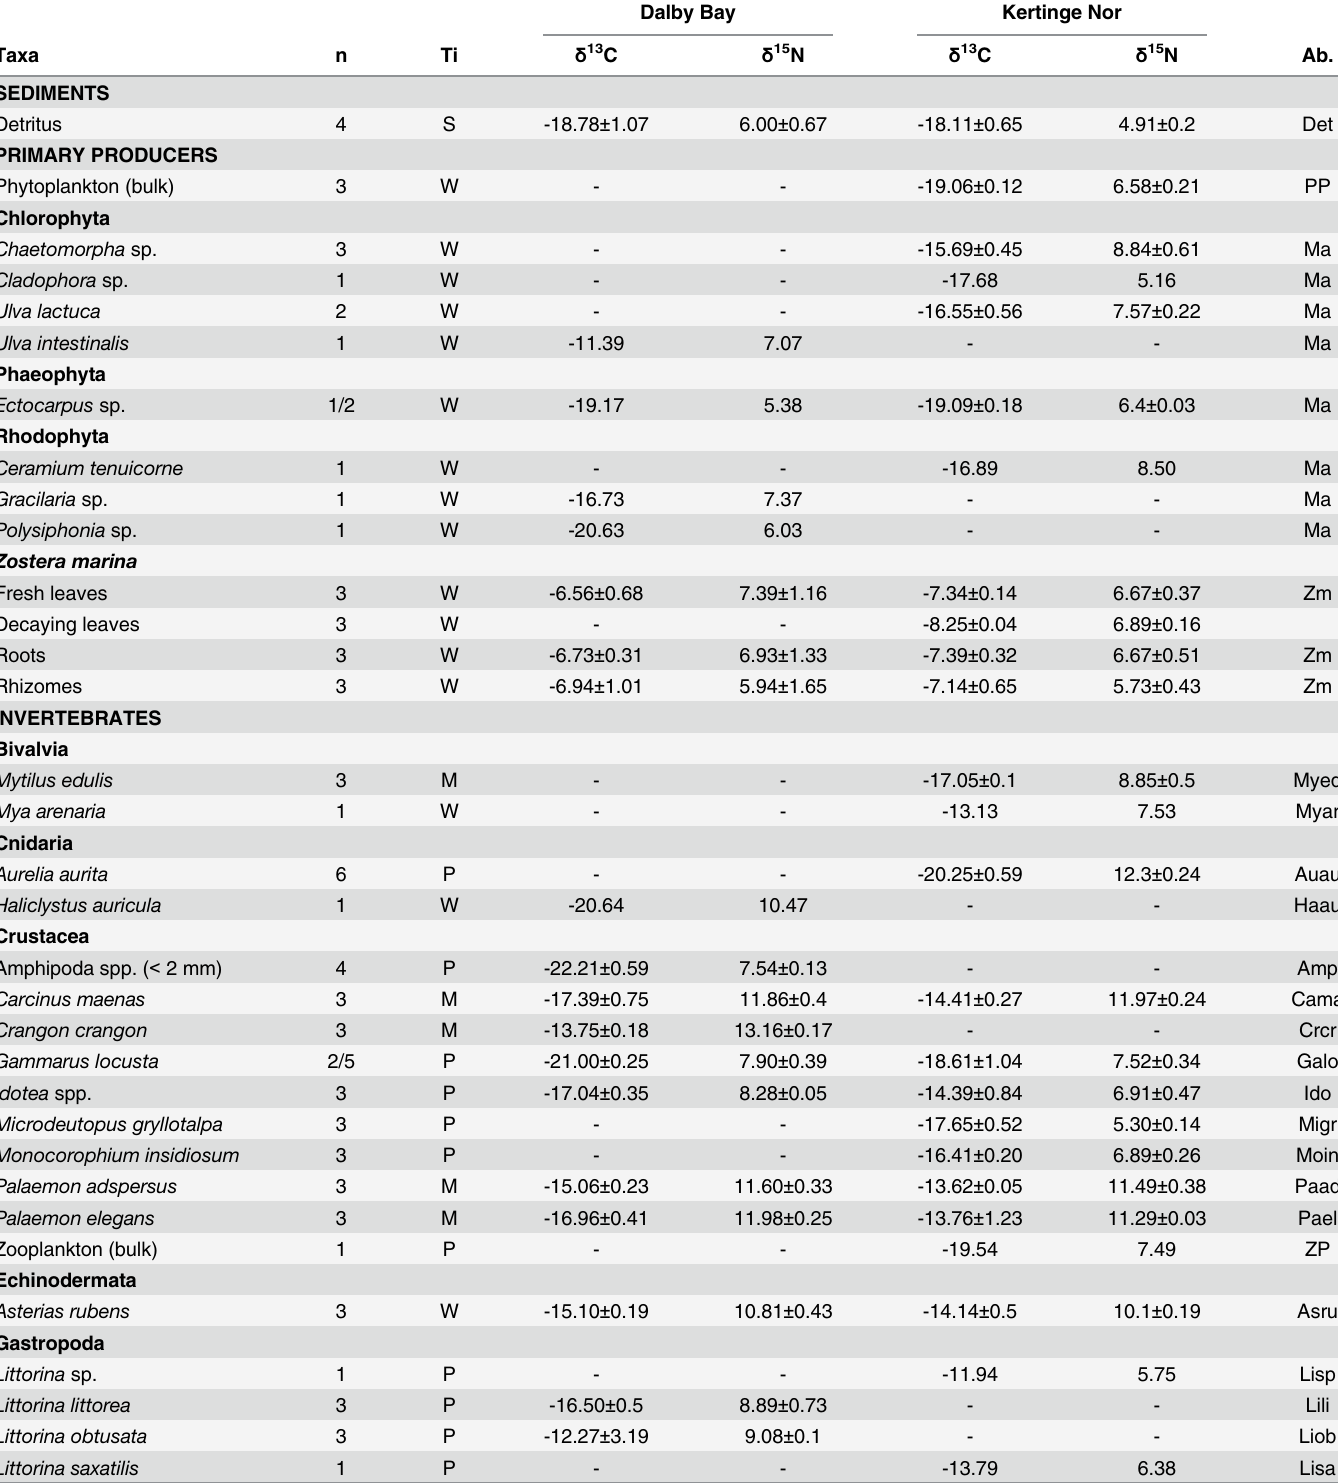
Table 3. Stable isotope δ 13 C and δ 15 N values (mean ± SEM) of primary sources and animal species associated to seagrass meadows in and Dalby Bay and Kertinge Nor in Denmark, June